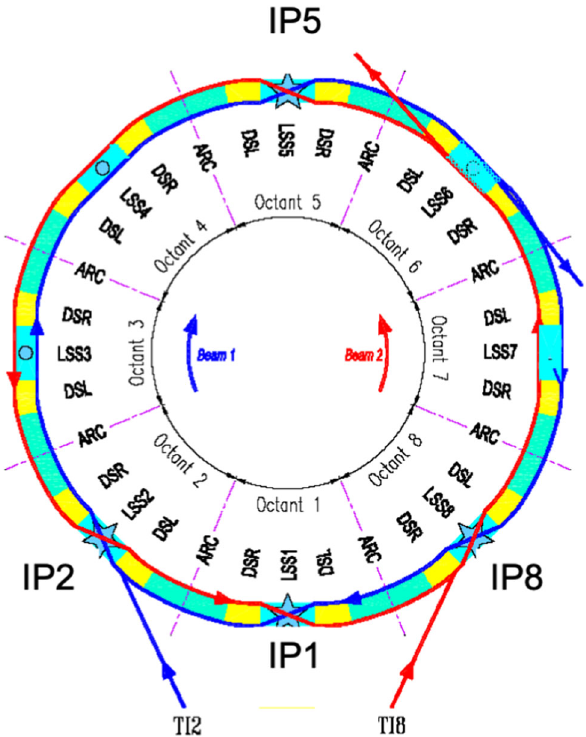
Fig. 16 Geometry of the two LHC beams, crossing from inner to outer ring in the four interaction points IP1, 2, 5 and 8 At the same time the non-colliding beam will see a relaxed optics with smallest achievable beam size in the proton mini beta quadrupoles. First estimates, based on an “injection type optics” with β ∗ of 15 m lead to an additional aperture request